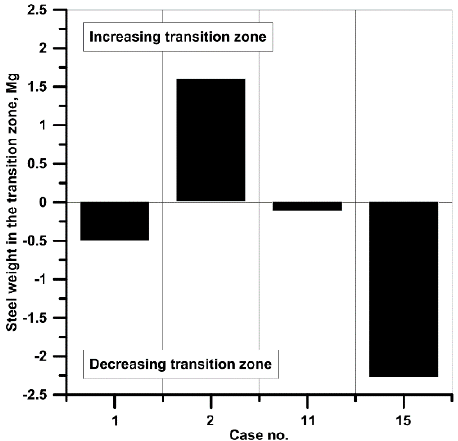
Figure 10. Transition zone for selected tundish variants.